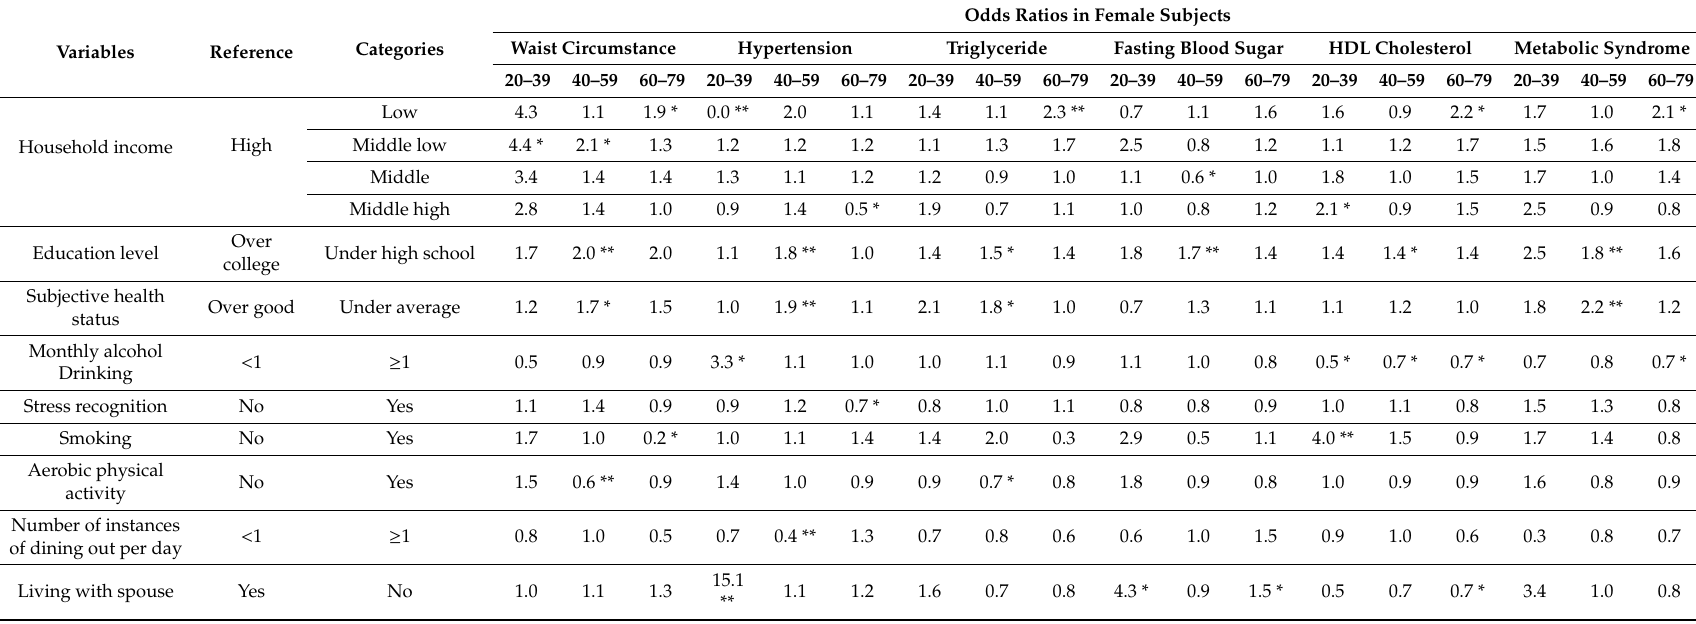
Table 4. Factors a ff ecting metabolic syndrome components in di ff erent female age